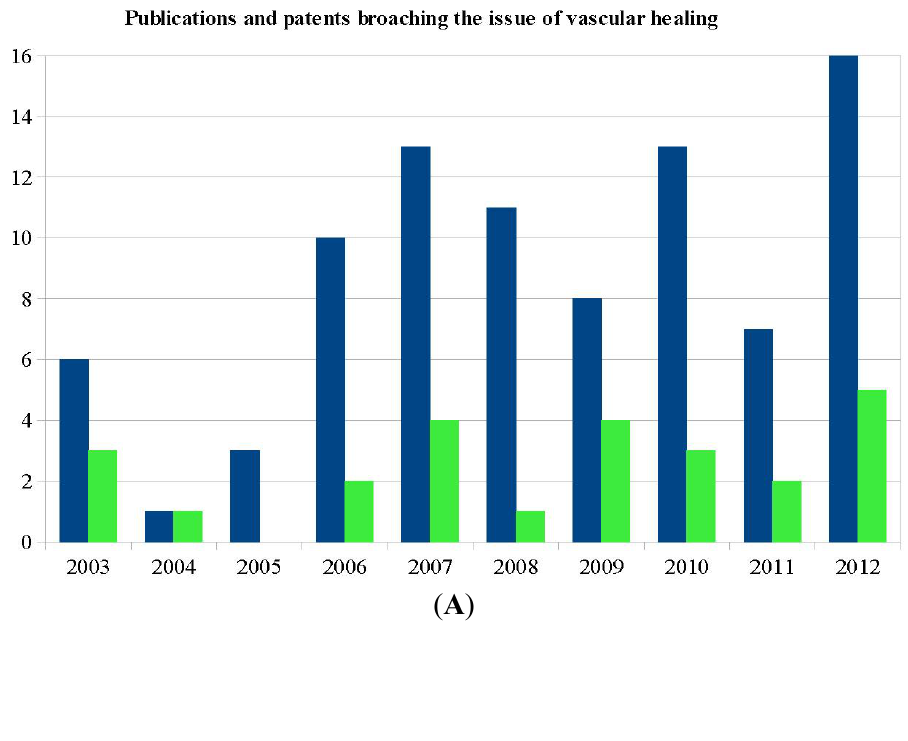
Figure 1. Publications and patents broaching the issue of vascular healing. ( A ) Publications (88) and patents (108) in the time period between 2003 and 2012 broaching the issue of vascular healing have been evaluated. The number of publications and patents is increasing after 2006 showing the growing interest in treating vascular diseases with stem cells and biomaterial. Blue: publications, green: patents; ( B ) Cell types for vascular healing approaches described in publications in the last decade. Embryonic stem cells were prominent in publications at the beginning of the decade. Their number decreased when in the iPS came up in the middle of the decade. Since iPS have a similar potency but cause less ethical problems and provide in addition the possibility for the future application of autologous cells, this was to be expected. Interestingly, the use of MSCs seems not to be affected by the development of induced pluripotent stem cell (iPS) cells. On the contrary, the use of this specific adult stem cell type is increasing. The reason for this might be the still unsolved risk of teratoma formation if endothelial cells (ECs) or IPS are used. ECs and smooth muscle cell (SMCs) have been described on a regular basis. The use of stem cells seems not to influence their utilization. Blue: EC, green: SMC, yellow: ESC, brown: MSC, orange: EPC, black: iPS, grey: other primary cells; ( C ) Cell types for vascular healing approaches described in patents during the last decade. The suggested used of the various cell types in patents follows the picture which can be seen in publications: The application of ECs is declining while the utilization of mesenchymal stem cell (MSC) which is the most prominent cell type. Blue: EC, green: SMC, yellow: ESC, brown: MSC, orange: EPC, black: iPS, grey: other primary